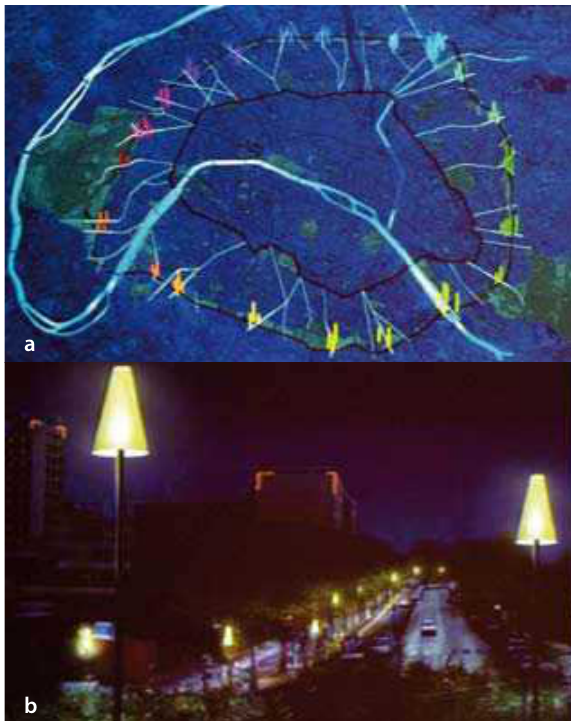
Fig. 2. Lighting masterplan “Paris Crown”,